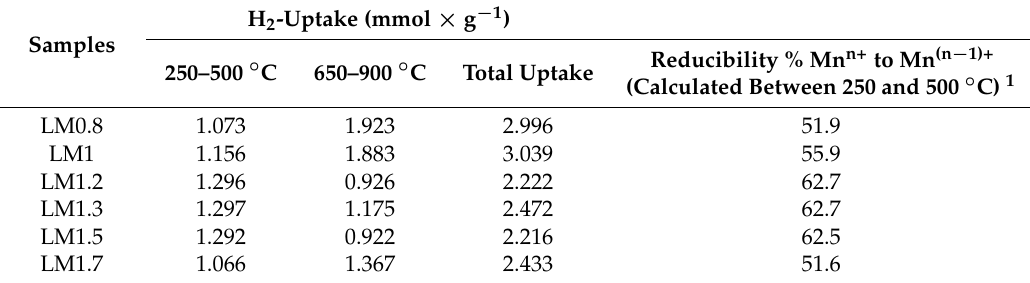
Figure 5. Temperature-programmed reduction by hydrogen (H 2 -TPR) profiles of selected LaMnO 3 catalysts. Table 2. Reduction temperature and H 2 uptake of selected LaMnO 3 samples.